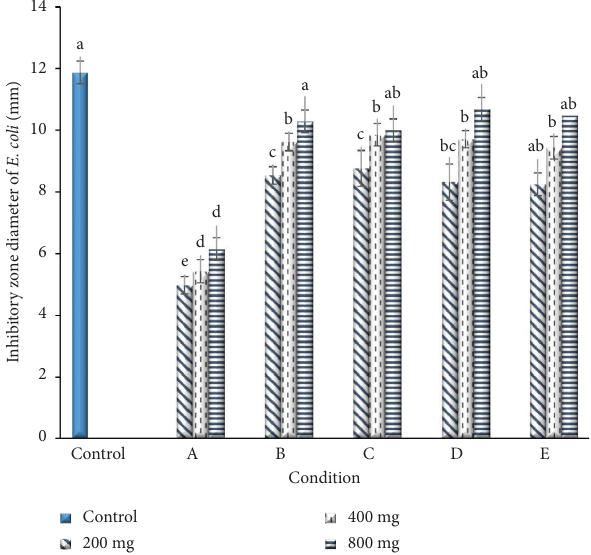
Figure 3: Growth inhibition zone of E. coli in diferent conditions. Control: gentamicin, A: enzyme ratio of 30AU/kg protein, 55 ° C and 210min; B: enzyme ratio of 60AU/kg protein, 50 ° C and 150min; C: enzyme ratio of 60AU/kg protein, 55 ° C and 180min; D: enzyme ratio of 90AU/kg protein, 50 ° C and 150min; E: enzyme ratio of 90AU/kg protein, 50 ° C for 180 min and control: repre- sented gentamicin as the control